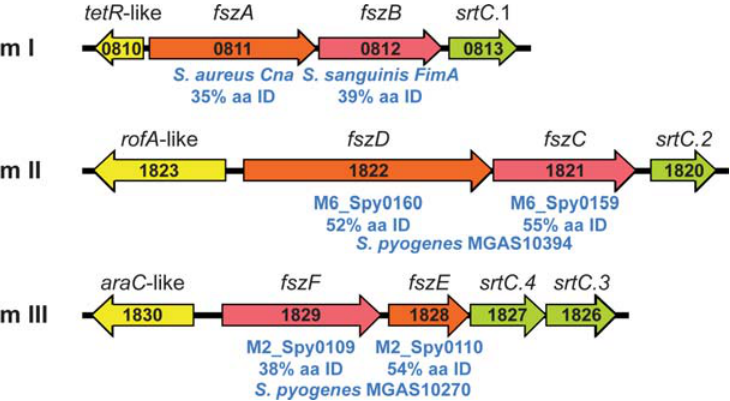
Figure 5. Schematic of three fimbrial operons . Illustrated are the 3 putative fimbrial operons identified in the MGCS10565 genome. Each operon has a gene encoding a protein homologous to the fimbrial backbone/major subunit protein (red) and an ancillary/minor subunit protein (orange). The genes encoding the fimbrial structural proteins are flanked at the 5 9 end (but oriented in the opposite direction) by genes encoding regulatory proteins (yellow) and at the 3 9 end by genes encoding sortases of the C-family (green). Gene numbers are given in black. Homologues of the structural proteins and their percent amino acid identity are given in blue. The putative major subunit proteins all have homology to GAS T- antigens, as expected.